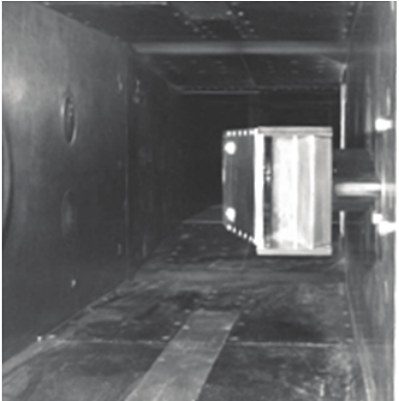
Figure 7. Ramjet’s air intake PSM mounted in the tested part of the WT